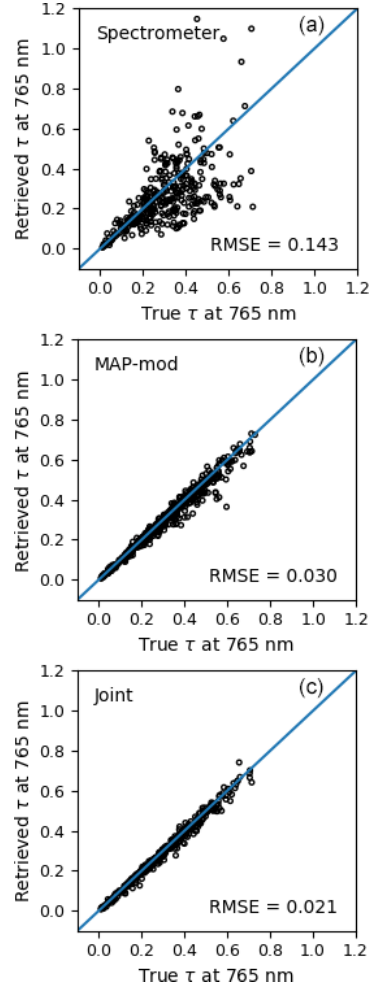
Figure B1. Aerosol optical thickness from spectrometer-only (a) , MAP-only (b) , and joint (c) retrievals compared to the true values. The diagonal solid lines outline the one-to-one